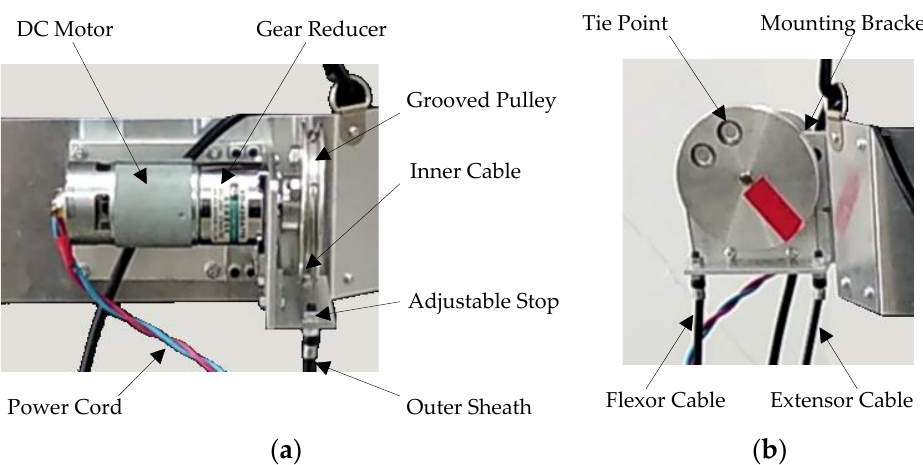
Figure 2. Actuator module used in the soft knee exoskeleton. ( a ) Front view of the actuator assembly. ( b ) Side view of the actuator assembly.